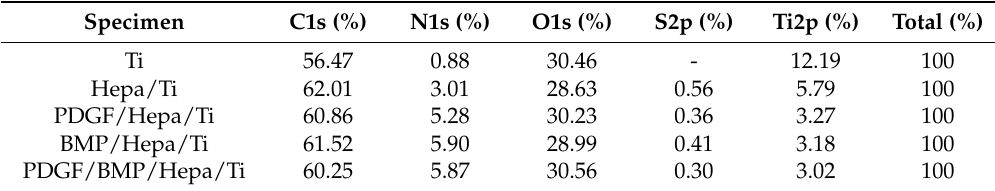
Table 1. Surface chemical compositions evaluated in 1 disc per group.